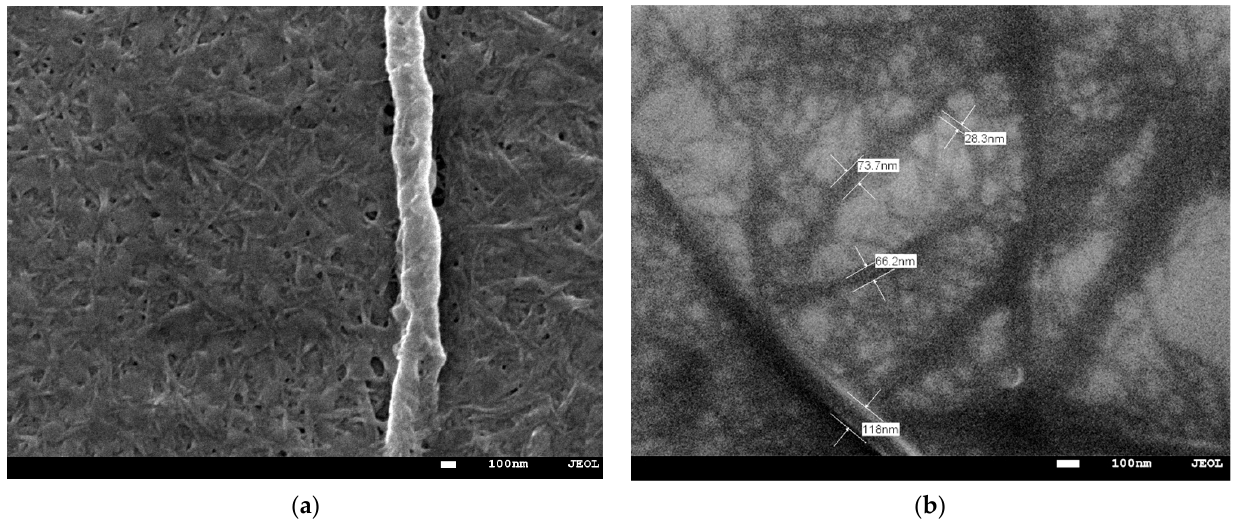
Figure 1. SEM images of CNC: ( a ) nanocellulose structure; ( b ) diameters of cellulose fibres.